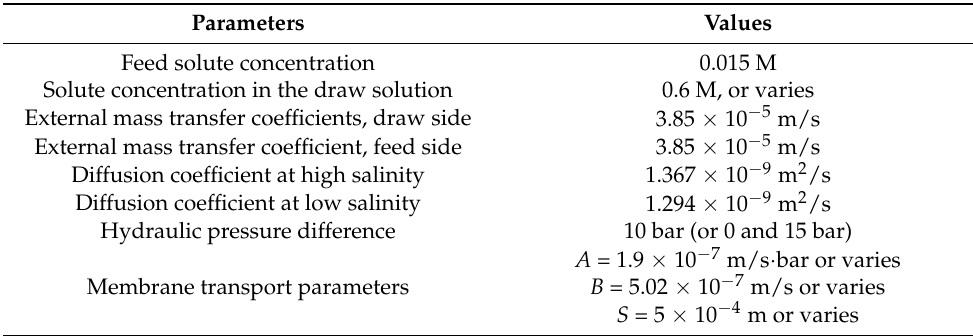
Table 2. General operating and transport